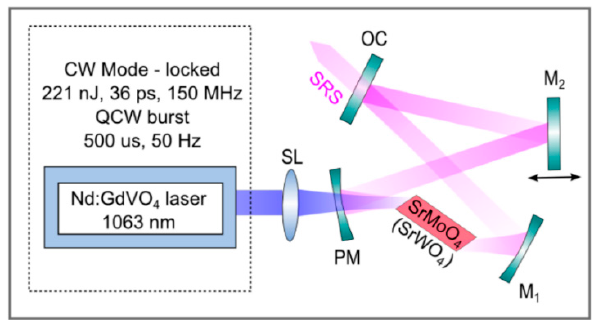
Figure 2. Experimental setup of synchronously pumped extra cavity crystalline Raman laser.